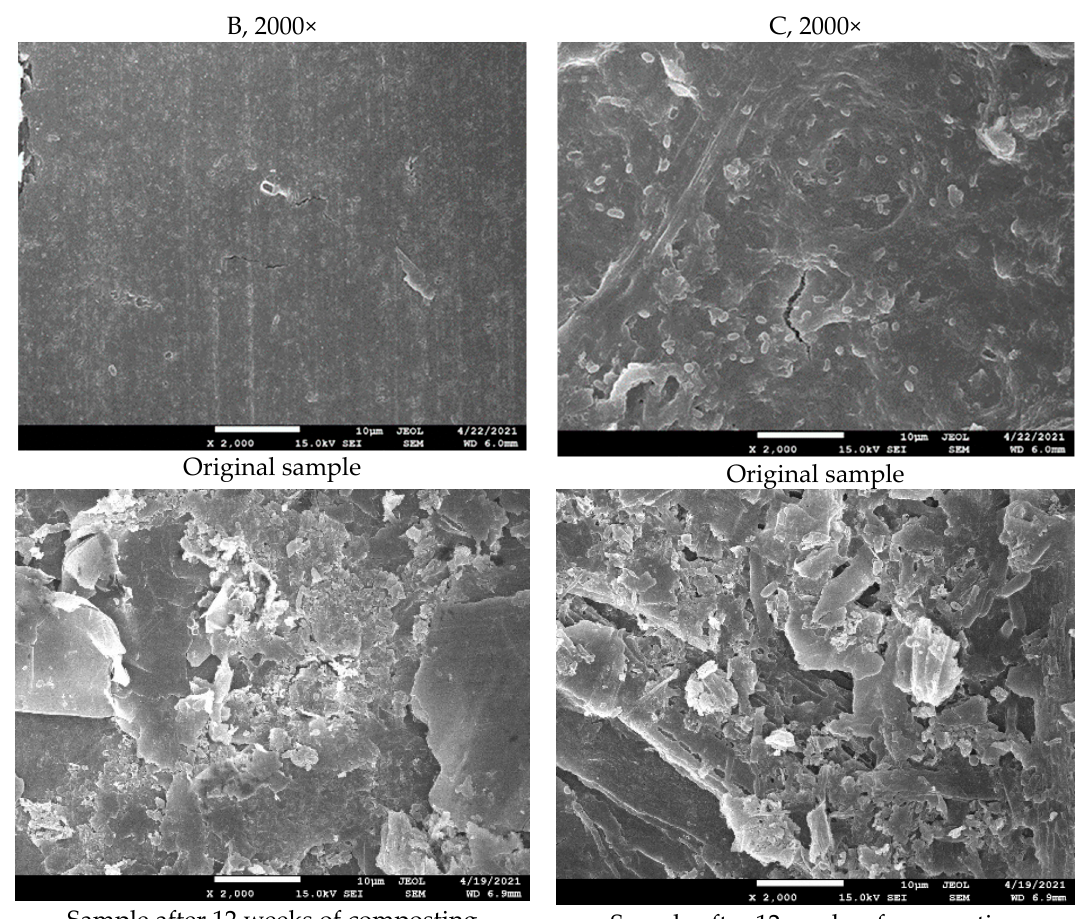
Figure 13. SEM images after 12 weeks of incubation at a municipal composting plant (second